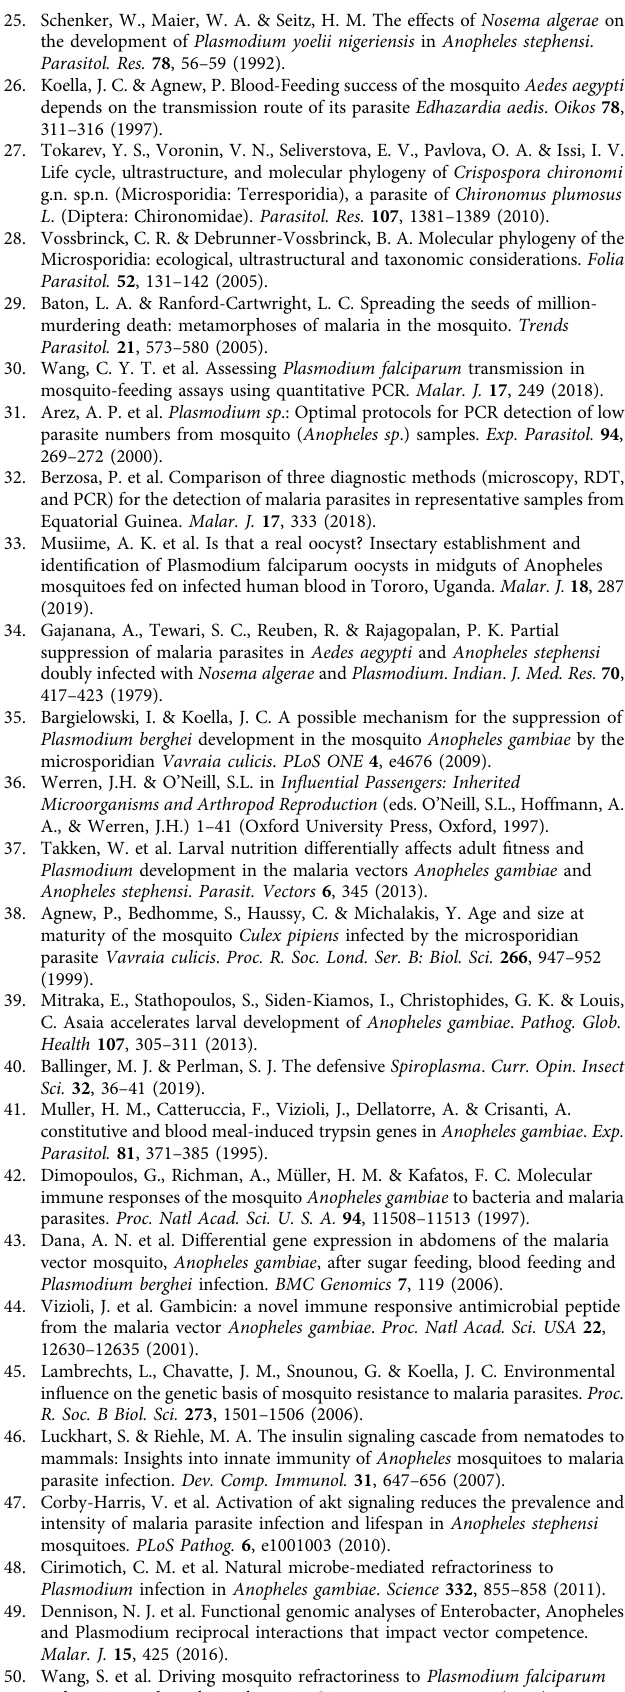
source data used to generate Figs. 2 – 5 and Supplementary Figs. 1 – 3 and Supplementary Tables 1 – 3 is available in the Source Data fi le. The Microsporidia MB 18S partial gene sequence has been submitted to Genbank with accession number MT160806[https:// www.ncbi.nlm.nih.gov/nuccore/MT160806]. The Anopheles arabiensis RNA